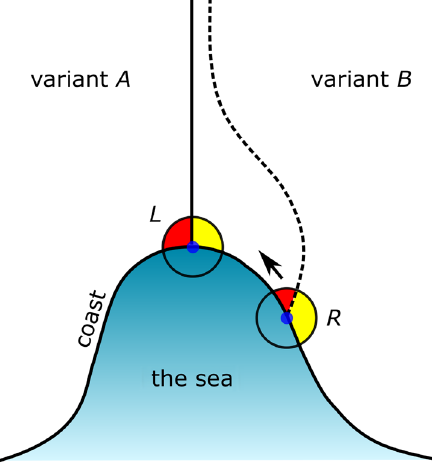
FIG. 5. Behavior of isoglosses at an indentation in coastline or other boundary (political or naturally occurring). Dashed isogloss is unstable and will evolve toward the solid isogloss which emerges perpendicular from the coast. We assume that both isoglosses are effectively anchored to a feature some distance away, opposite the boundary shown. Speakers are shown as blue dots, and colors have the same meanings as in Fig.